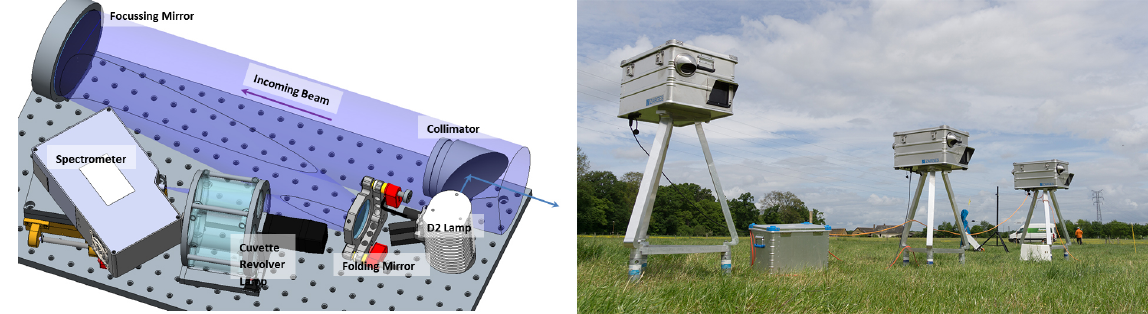
Figure 1. Swiss miniDOAS scheme and field set-up of three instruments (retro-reflectors and shutter not shown).